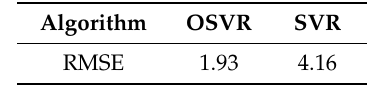
Table 9. The estimation error of OSVR and